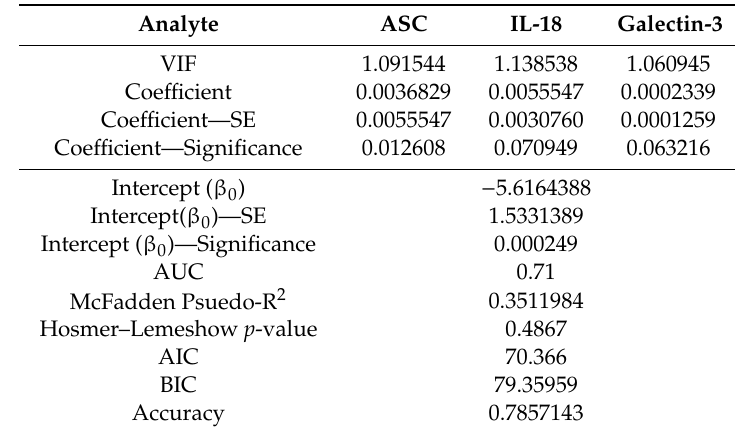
Table 4. Multivariate